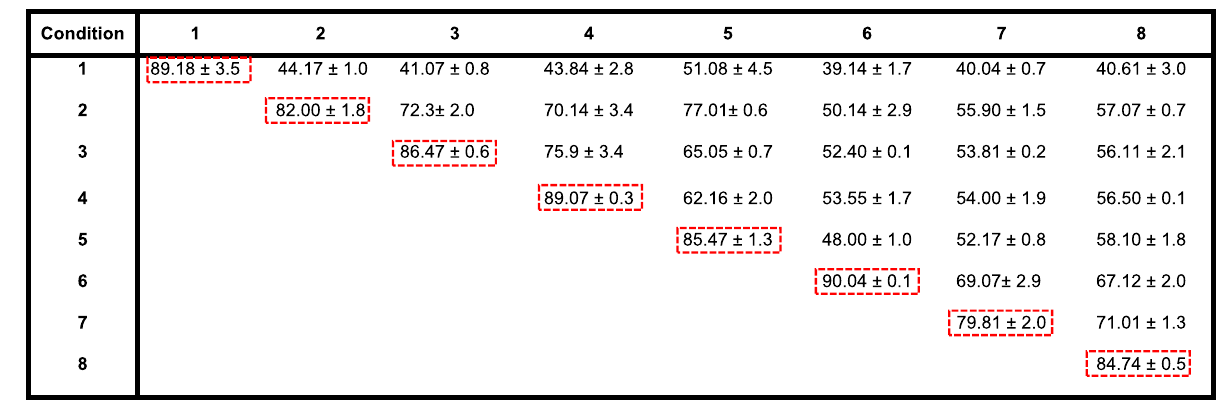
Table 5. Mean (± SD) similarity scores of gaze sequences across the 8 obstacle conditions. Red dashed squares indicate similarity within each obstacle condition. The numbers 1–8 represent the obstacle conditions as